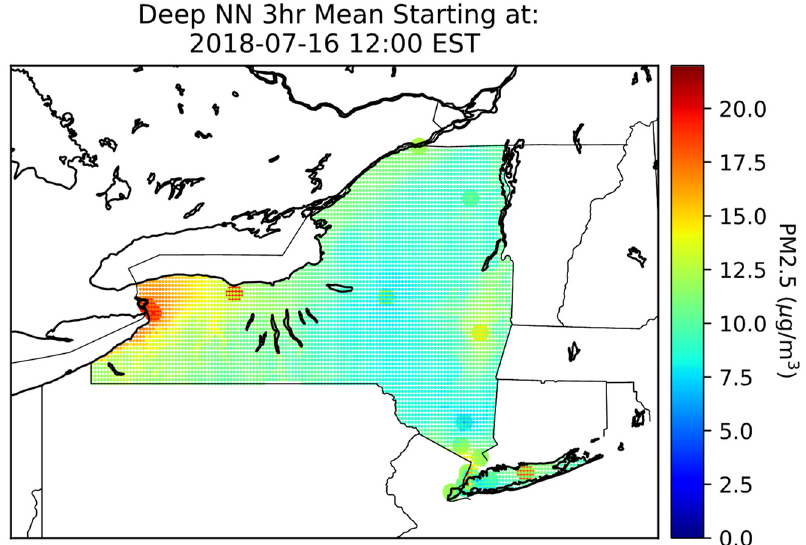
Figure 6. Spatial interpolation over NYS using a DNN regressor on top of simple Kriging.